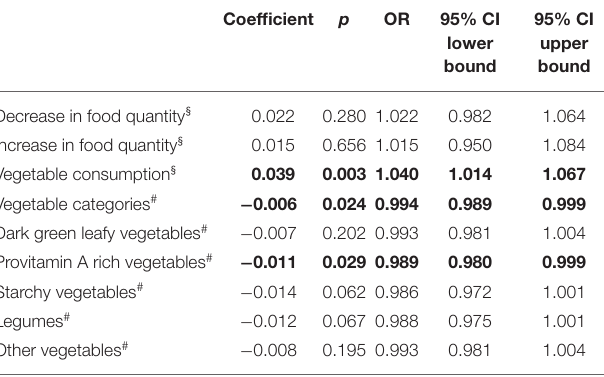
TABLE 5 | Results of binary logistic and Poisson regressions for the independent variable “perceived price